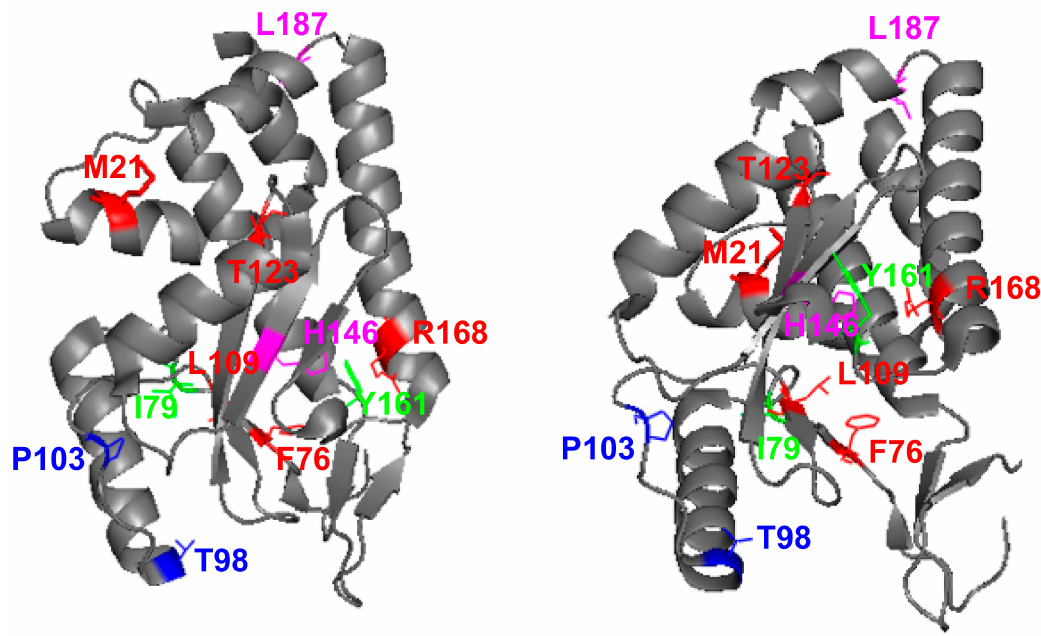
Figure 8. Location of identified amino acid mutations in pH1N1 PA. The N-terminal region of pH1N1 PA protein (Accession #AY818132) is shown in two different views using the same coloring code. PA is indicated in gray. Location of amino acids M21, F76, L109, T123, R168 (red), T98/P103 (blue), I79/Y161 (green), and H146/L187 (magenta) are shown in the background of the PA. The crystal structure figure was adapted from PDB: 4AVQ using